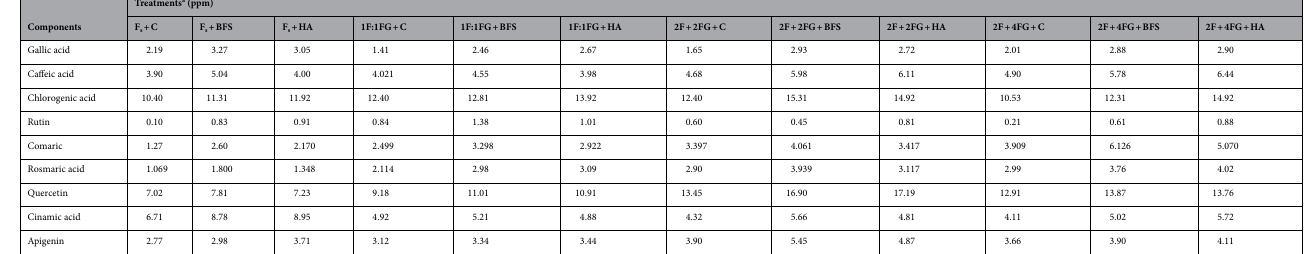
Table 5. Concentration of phenolic compounds in fennel under different cropping patterns and fertilization. a C (control), BFS (biofertilizers), HA (humic acid), and Fs (fennel sole cropping), 1F:2FG, 2F:2FG, and 2F:4FG are the ratios of fennel and fenugreek in the intercropping